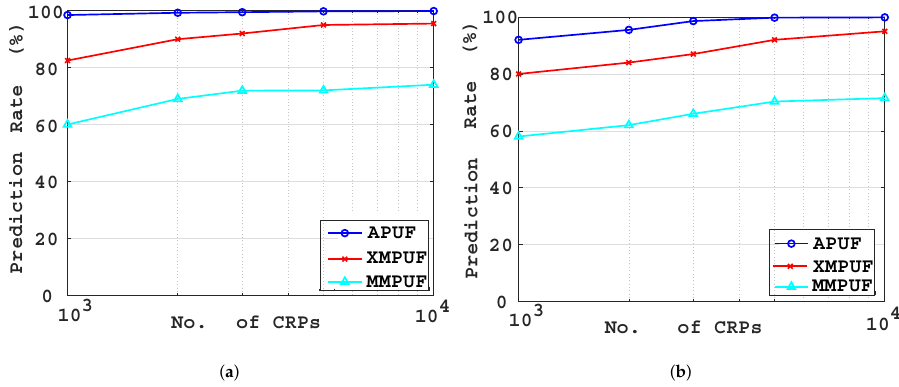
Figure 11. The prediction rates of CMA-ES attack on: ( a ) 64 bit and, ( b ) 128-bit MMPUF